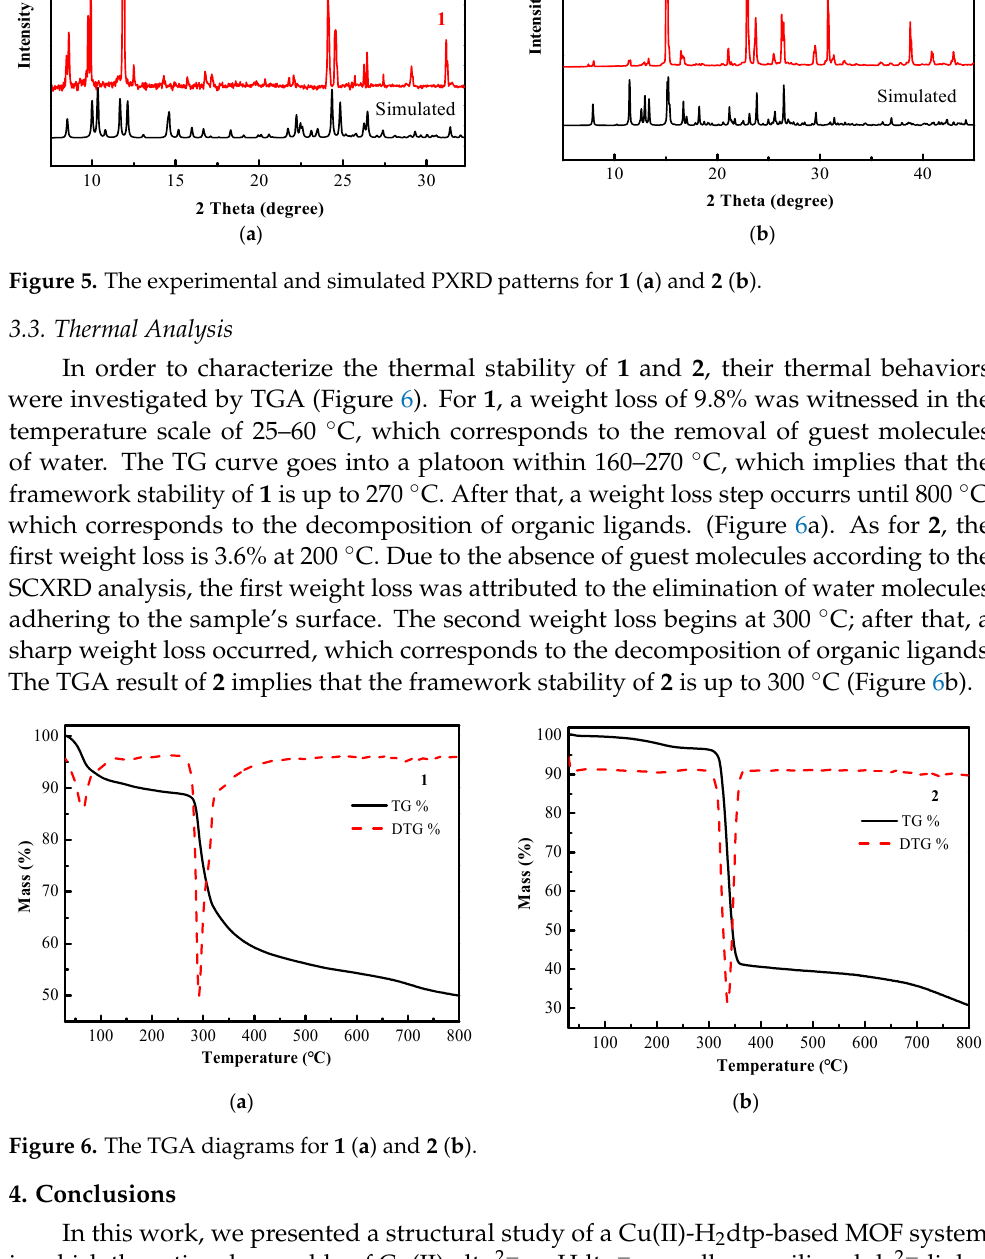
Figure 6. The TGA diagrams for 1 ( a ) and 2 ( b ).